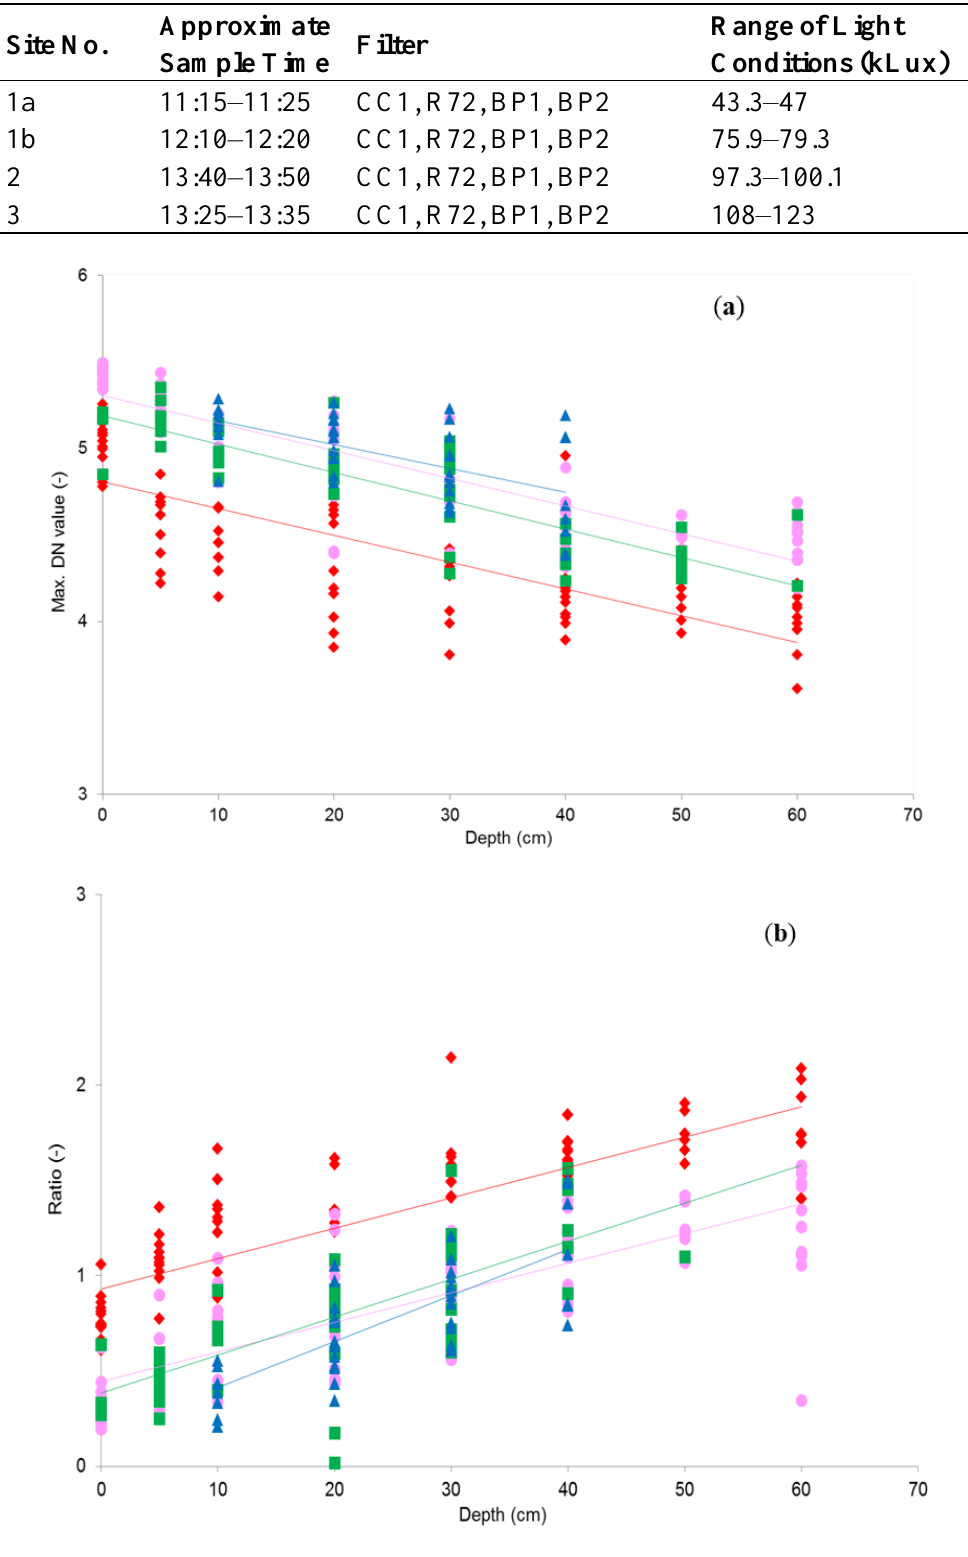
Figure 5. Natural logarithm of maximum DN values versus sample depth for samples from all sites for ( a ) NIR(R72); ( b ) Red/NIR(BP2) ratio. Sample numbers per site: site 1a (♦; n = 87), site 1b (●; n = 84), site 2 (■; n = 47) and site 3 (▲; n = 30). All shown model coefficients are significant at α =